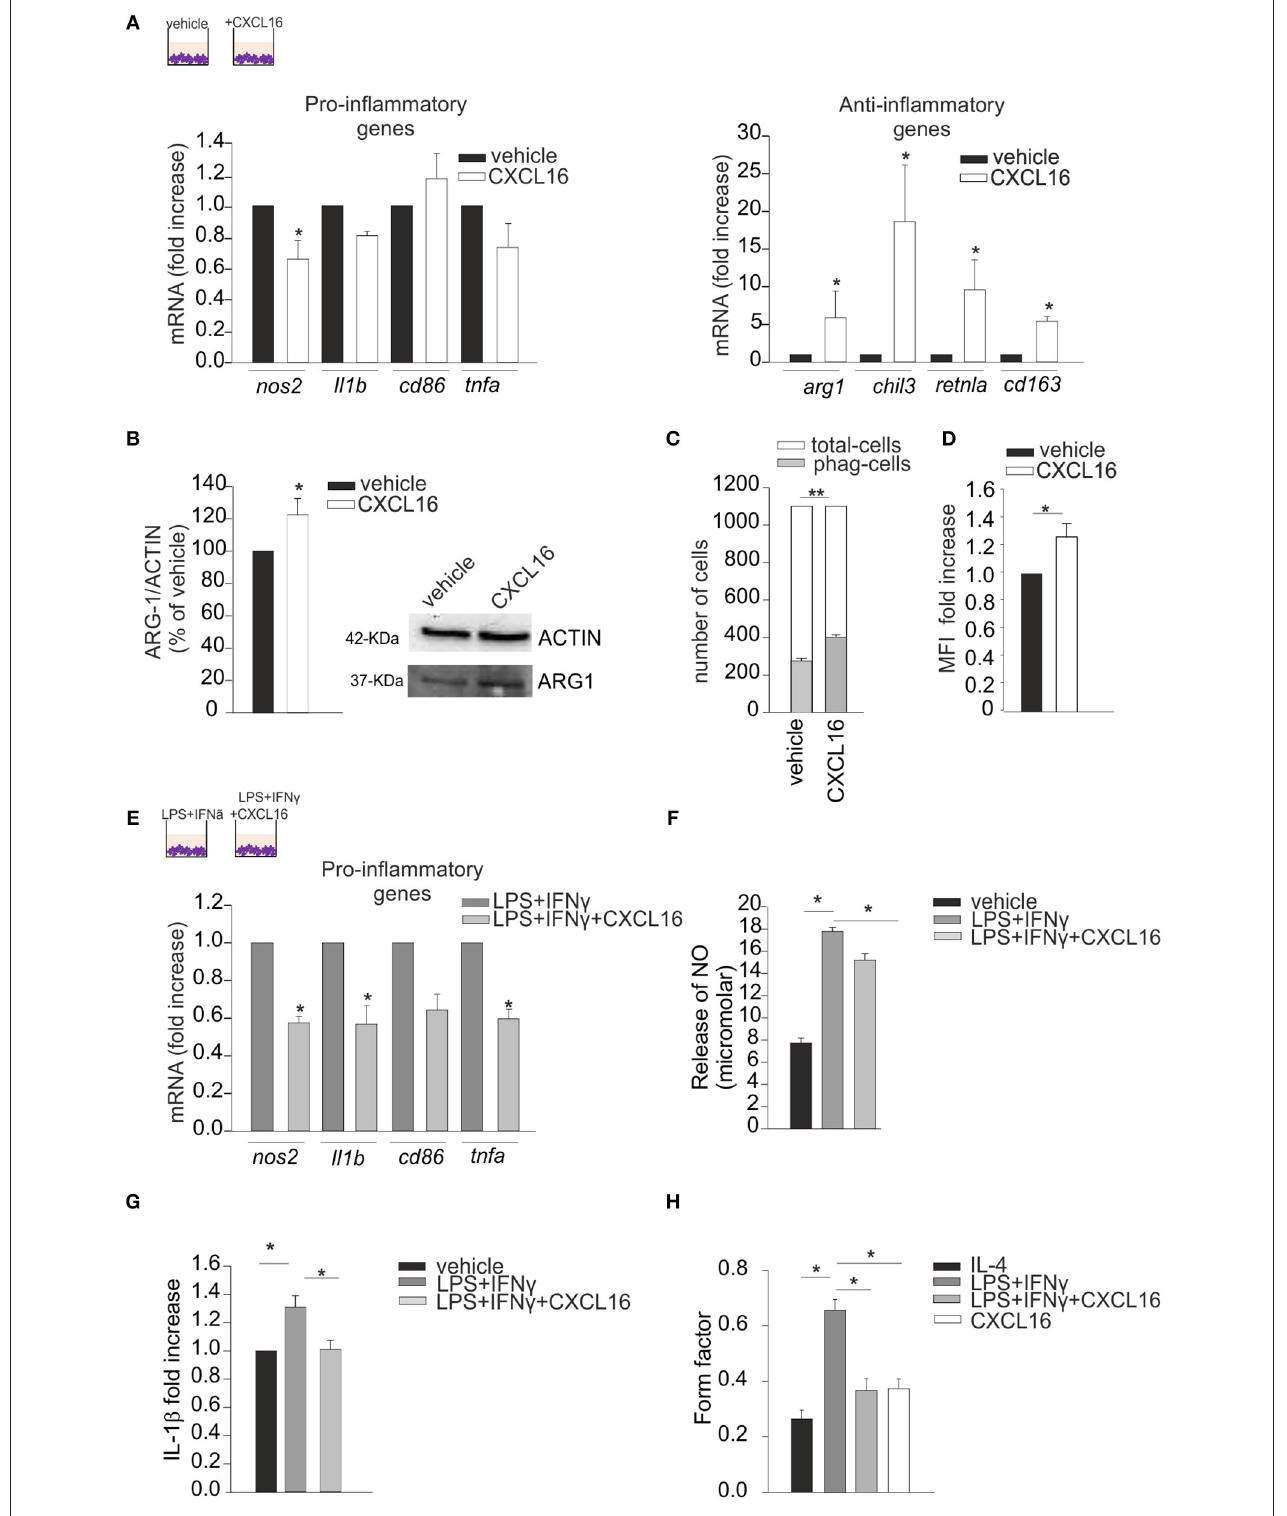
FIGURE 1 | Effects of CXCL16 in modulating microglia phenotype. Expression analysis by RT-qPCR for mRNAs of pro-inflammatory ( nos2, il1b, cd86, tnfa ) or anti-inflammatory (a rg1, chil3, retnla, cd163 ) related genes in primary wt microglia treated with: (A) vehicle or CXCL16 (200nM); (E) LPS + IFN γ